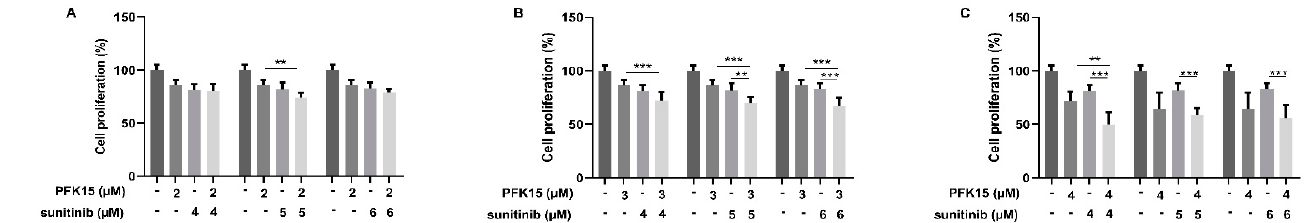
Figure 3. Effect of PFK15 (( E )-1-(pyridin-4-yl)-3-(quinolin-2-yl)prop-2-en-1-one) and sunitinib ad- ministered alone or in combination on HUVEC proliferation. HUVEC were treated with PFK15 at 2 ( A ), 3 ( B ), or 4 ( C ) µM and sunitinib at 4, 5, or 6 µM for 72 h. Changes in cell proliferation were recorded. Statistical differences among groups were determined by one-way ANOVA followed by Tukey’s post hoc test. Data are presented as the mean ± SEM of three independent experiments (** p < 0.01; *** p < 0.001).